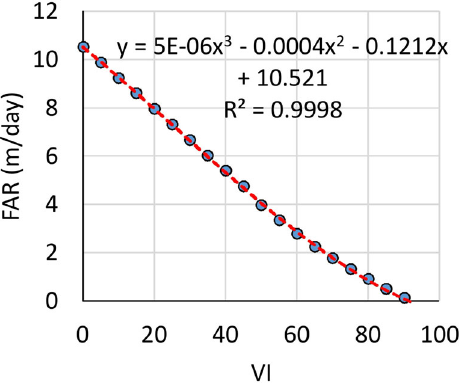
Fig. 7 Calculated final equation to prediction of FAR for Parvadeh-I coal mine